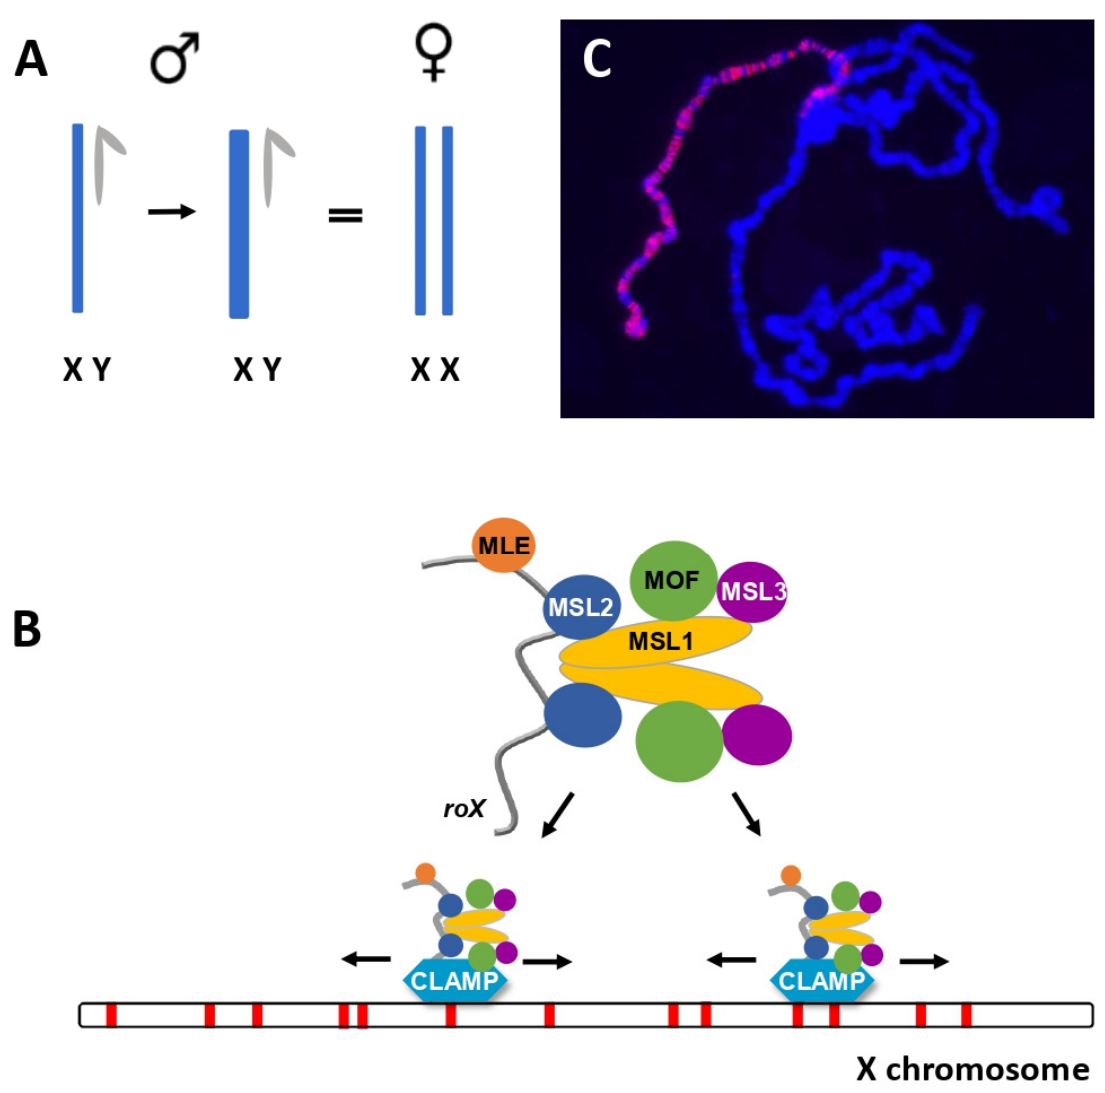
Figure 1. Dosage compensation in Drosophila equalizes sex chromosome expression between males and females. ( A ) Drosophila males have one X chromosome while females have two. Males increase transcription from their X-linked genes approximately two-fold to equalize expression. ( B ) The Male Specific Lethal (MSL) complex, composed of five proteins and a long non-coding RNA, is recruited to CLAMP-bound Chromatin Entry Sites (red) on the X chromosome. The MSL complex then spreads in cis to nearby transcribed genes by recognition of active chromatin marks. ( C ) Polytene chromosome preparation from a wild type male. MSL2, detected by Texas Red, identifies the X chromosome. DNA is counterstained with DAPI